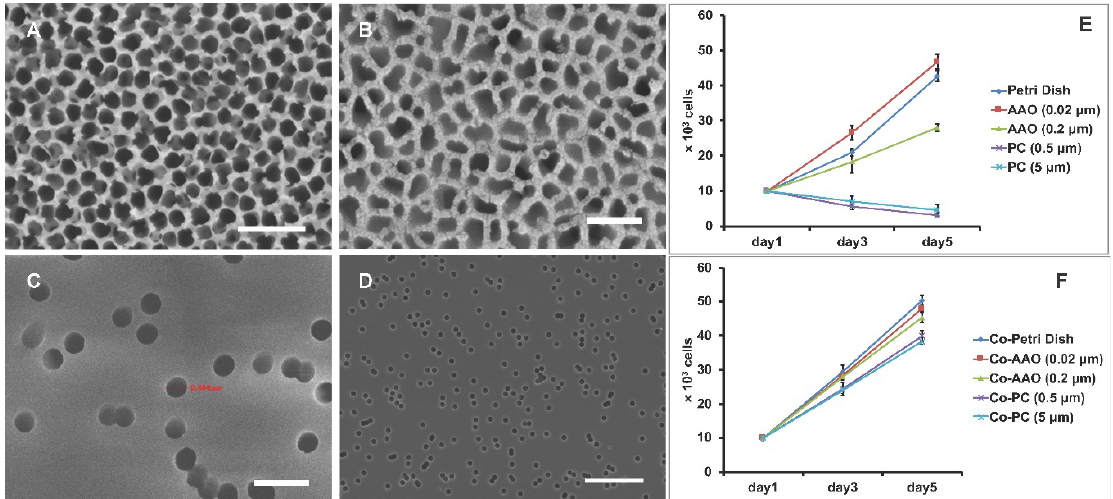
Figure 2. SEM images for AAO membrane with ( A ) 0.2 μm and ( B ) 0.02 μm pores, and PC membrane with ( C ) 0.5 μm and ( D ) 5 μm pores. Scale bar, 1 μm ( A , C ), 100 nm ( B ), and 50 μm ( D ). ( E ) The growth curve of podocytes on AAO or PC membrane without collagen coating. ( F ) The growth curve of podocytes on AAO or PC membrane with collagen coating. For ( E , F ), data are shown as mean ± SD ( n = 3).